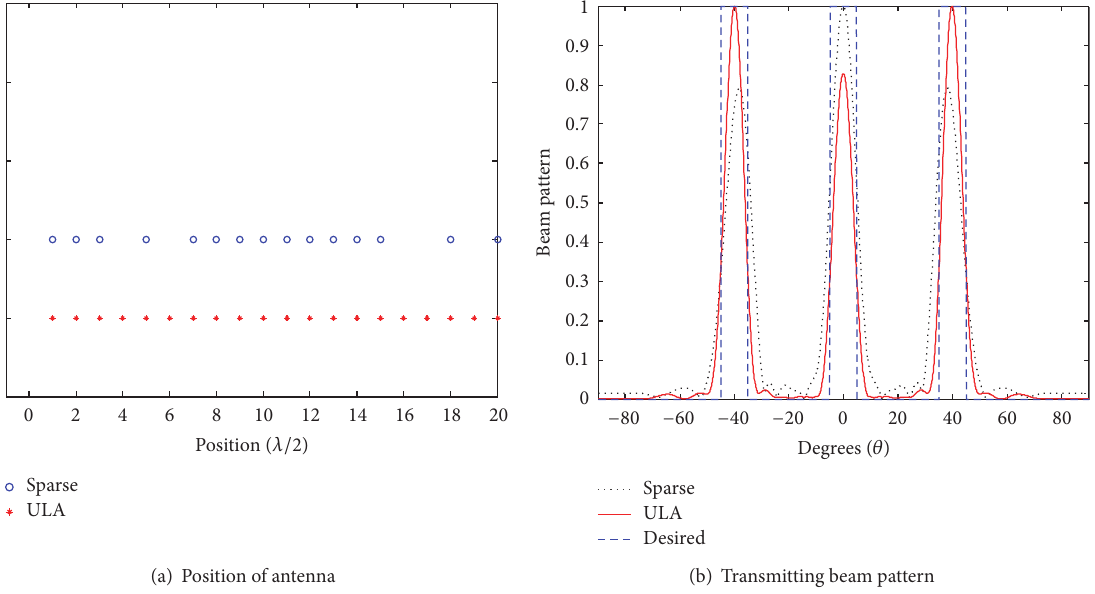
Figure 6: Results of DE with mutation strategy 3.